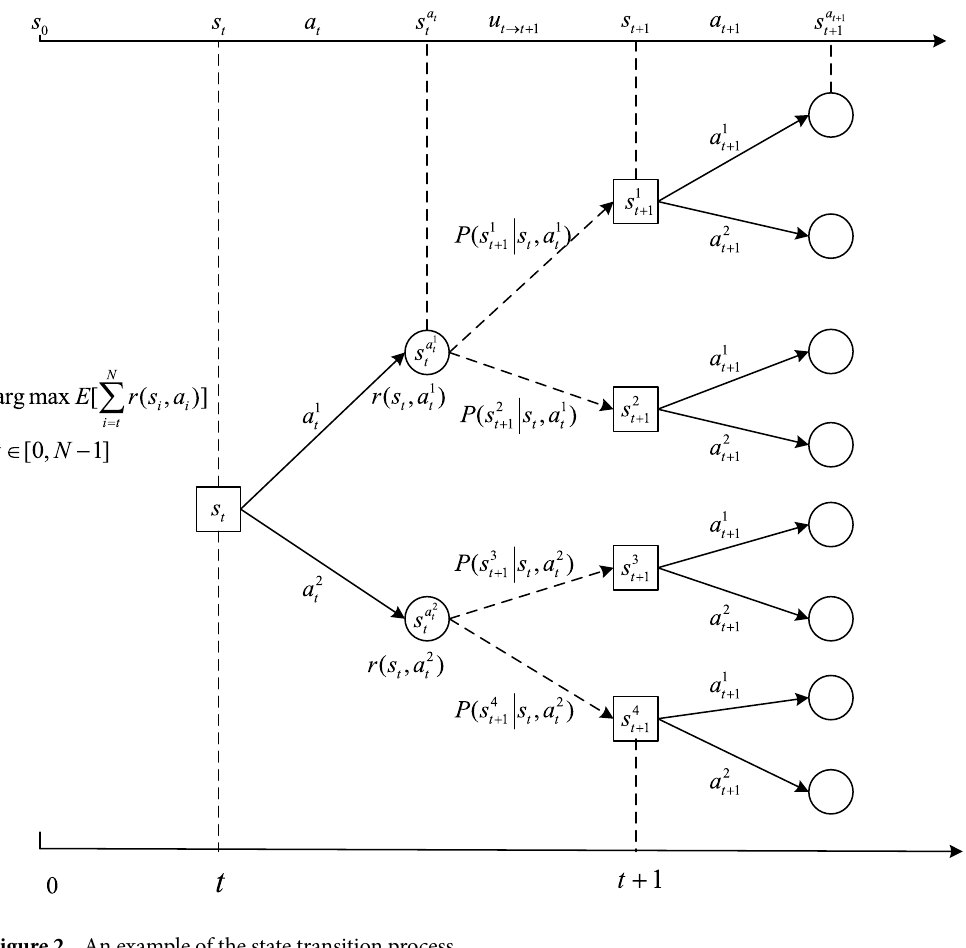
Figure 2. An example of the state transition